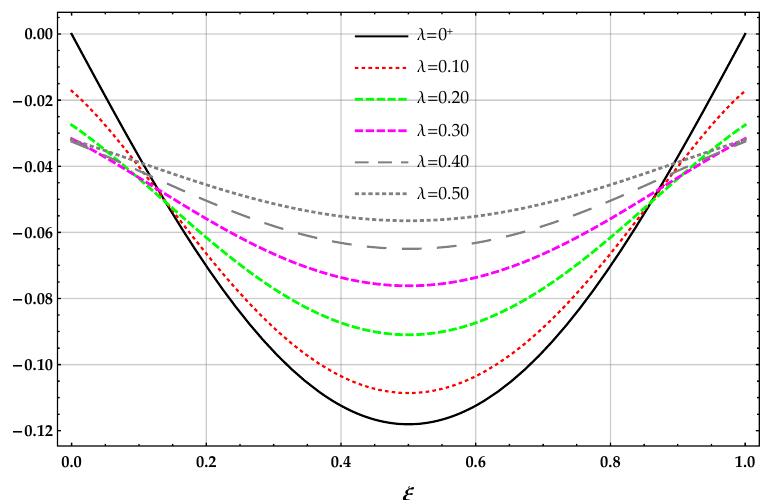
Figure 7. SS − q beam. DD method: plots of the non-dimensional reaction r ∗ of the elastic foundation for increasing values of the non-dimensional non-local parameter λ in the set with k ∗ =